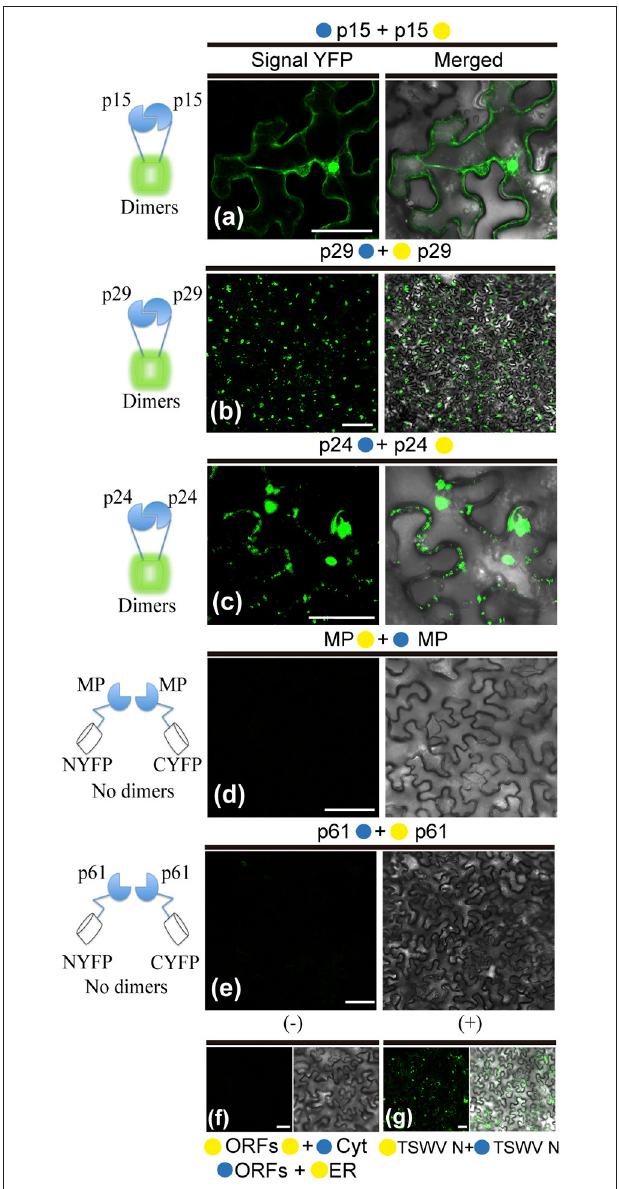
FIGURE 7 | BiFC analyses of dimer formation between proteins of Citrus leprosis virus C . p29, p15, p61, MP, and p24 carrying N-terminal (•) or C-terminal (•) YFP fragments fused at their N- (•/•–ORFs) or C-termini (ORFs-•/•) were transiently co-expressed in N. benthamiana leaves by agroinfiltration. Confocal microscopy images corresponding to the representative fusion protein pair combination assayed for p29-p29, p15-p15, p61-p61, MP-MP, and p24-p24 interactions (a synthesis of all protein pair combination performed) are shown in Table 1 . All images contain two pictures corresponding to the YFP signal or merged with bright field. (a) p15 dimerization with YFP signal located in the nucleus and cytoplasm. (b) p29 dimerization with YFP signal located throughout cytoplasm forming inclusions and punctate bodies. (c) p24 dimerization with YFP signal in format of vesicle-like spherical structures dispersed by cytoplasm. (d,e) No fluorescence return from MP or p61 BiFC expression. Negative controls correspond to theexpressionoftheCiLV-CproteinsincombinationwithCytorERBiFCvectors (Continued)